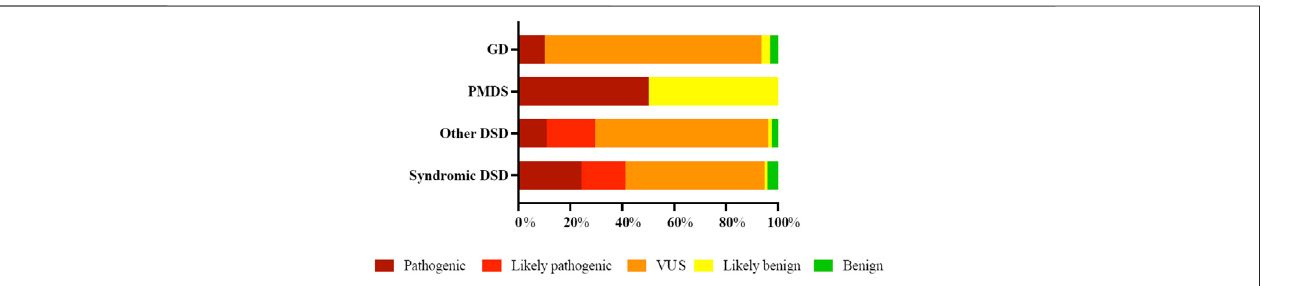
FIGURE 2 | Distribution and percentage of curated 258 variants at different evidence levels in the fourth categories of patients with 46, XY DSD as de fi ned in Table4 .Thepercentagesrefertoonlytothevariantsthatareclassi fi edineachpatientcategory.*DSD,disordersofsexdevelopment,GD,gonadaldysgenesis,PMDS, persistent Müllerian duct syndrome, VUS, variant of uncertain signi fi cance.